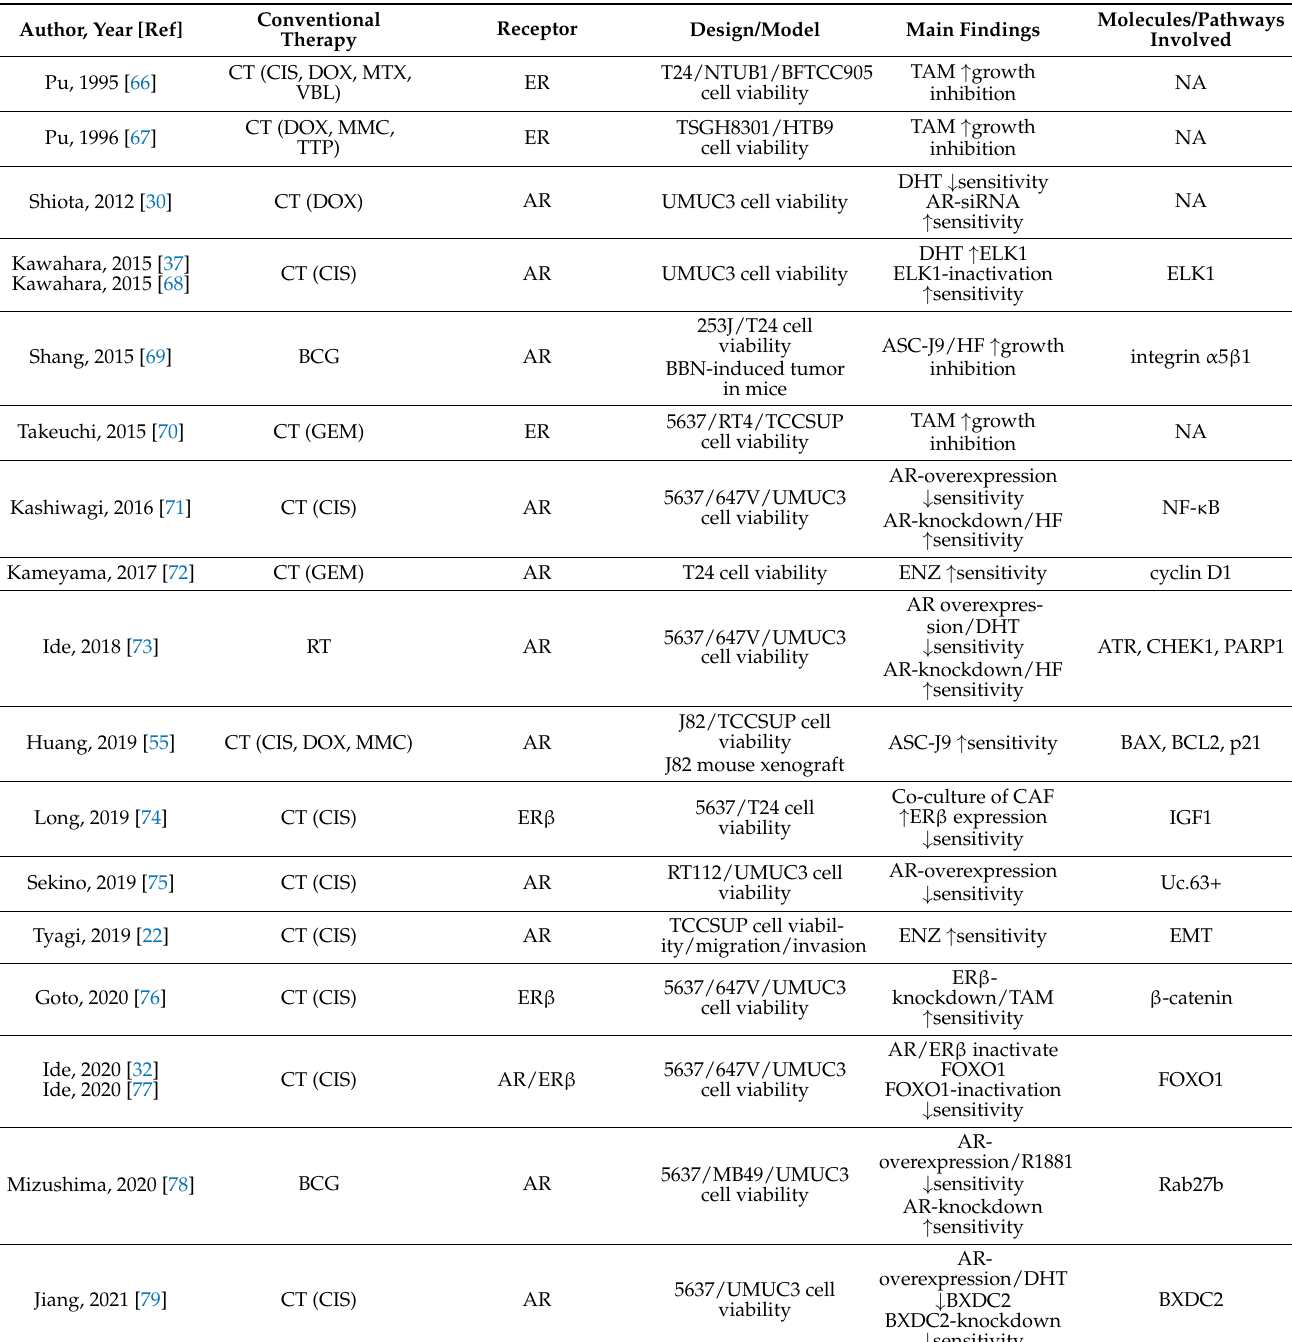
Table 4. Preclinical studies suggesting the involvement of AR/ER signaling in modulating sensitivity to conventional therapy for bladder